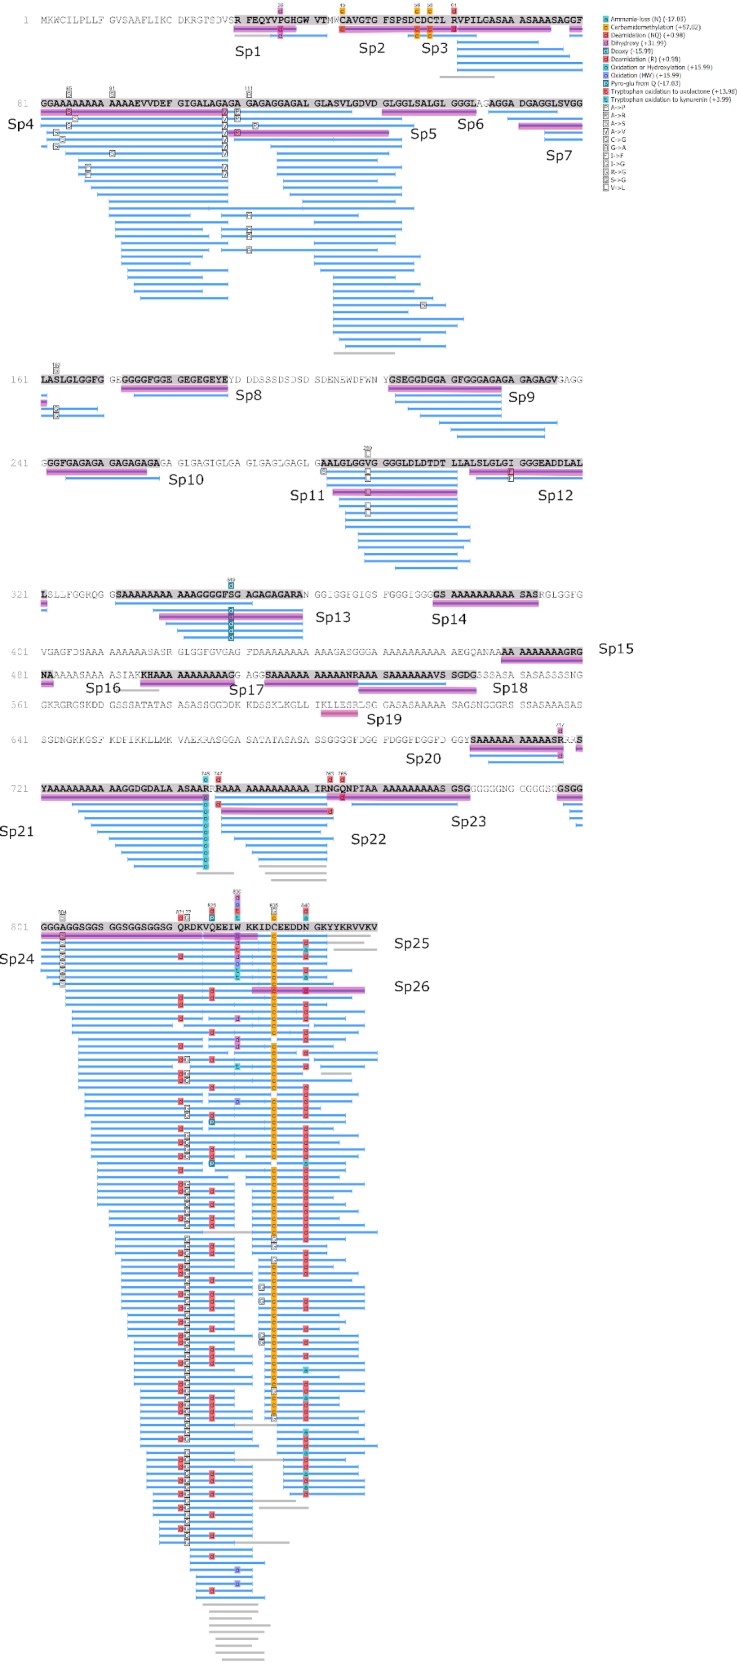
Protein Hic74 identified in the double-button HavC: sequence coverage, highlighting in pink the product ion spectra ('Sp') shown below.Sequences reconstructed by assisted de novo on the basis of mono-charged ions mainly (spectra were acquired on the 400-1600 m/z range and multiply-charged ions were detected).